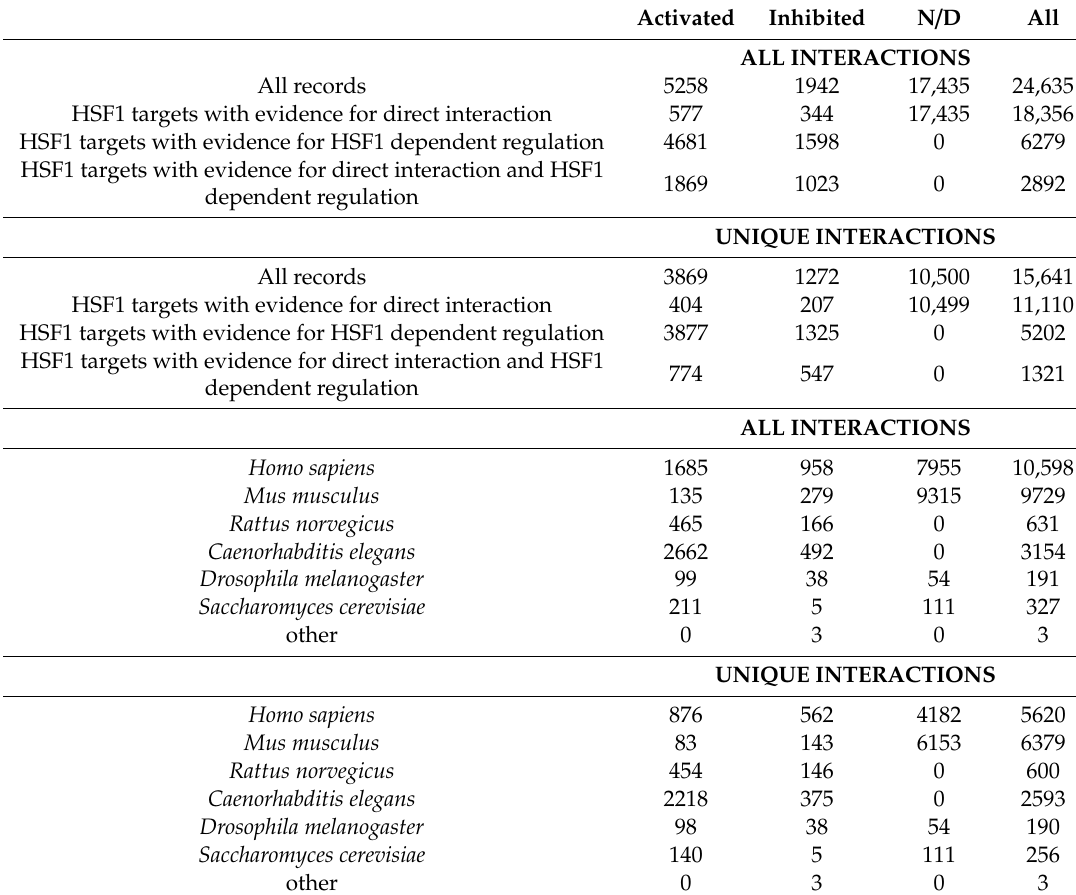
A table summarizing the HSF-1 targets found in the database HSF1base ( hsf1base.org ). The ‘activated’ gene expression is upregulated by HSF-1. The ‘inhibited’ gene expression is downregulated by HSF-1. ‘N / D’ means there is no regulatory information available. ‘All interactions’ contains all entries in the database; duplicates are included. ‘Unique interactions’ does not contain duplicates; every gene is included only once. ‘HSF1 targets with evidence for direct interaction’ are considered as such based on evidence for physical interaction between HSF1 and the corresponding gene. In case of ‘HSF1 targets with evidence for HSF1 dependent regulation’, regulatory information is available, but there is no evidence for physical interaction between HSF1 and the corresponding gene. For ‘HSF1 targets with evidence for direct interaction and HSF1 dependent regulation’, both regulatory information and evidence for physical interaction are